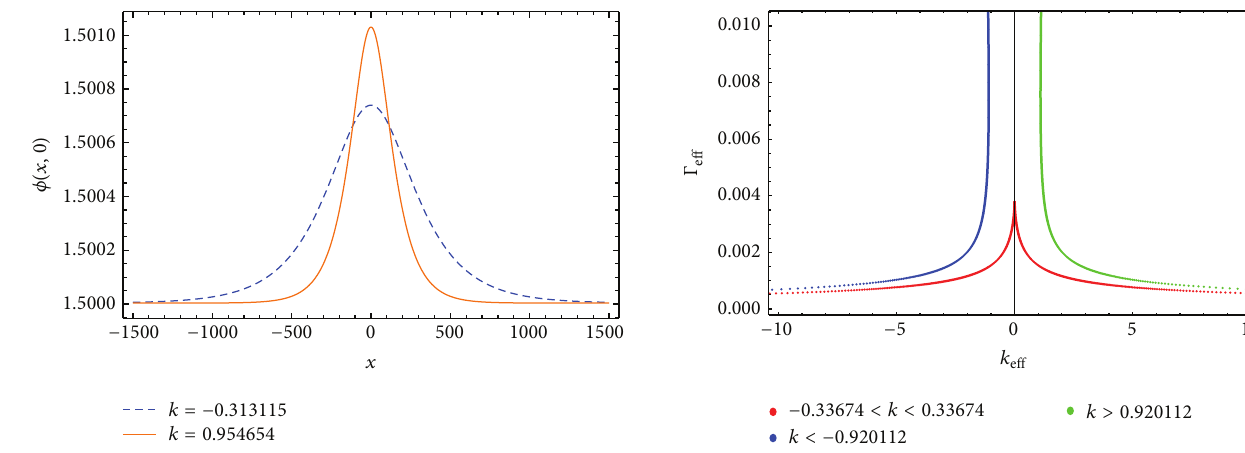
Figure 2: Oscillon (thin line) and its phantom (dashed line) for 𝑡 = 0 , 𝜖 = 0.01 , 𝑎 = 1.2 , 𝜆 = 10 −5 , and 𝑏 = 0.01 .